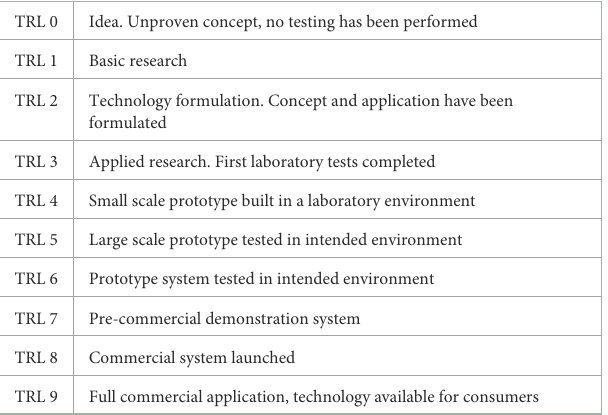
TABLE 2 The technology readiness levels scale